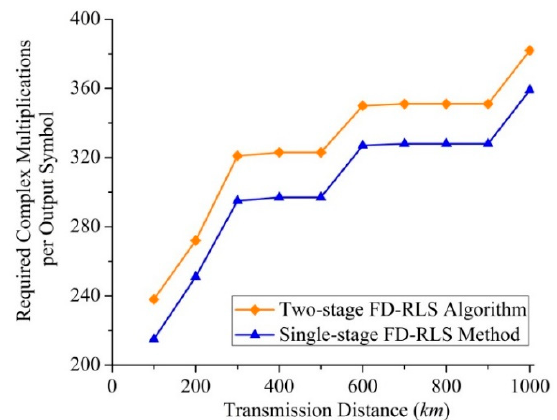
Figure 27. The required complex multiplications per output symbol of the two-stage and single-stage frequency-domain (FD)-RLS approaches as a function of transmission distance in an FMF-based transmission system [10].